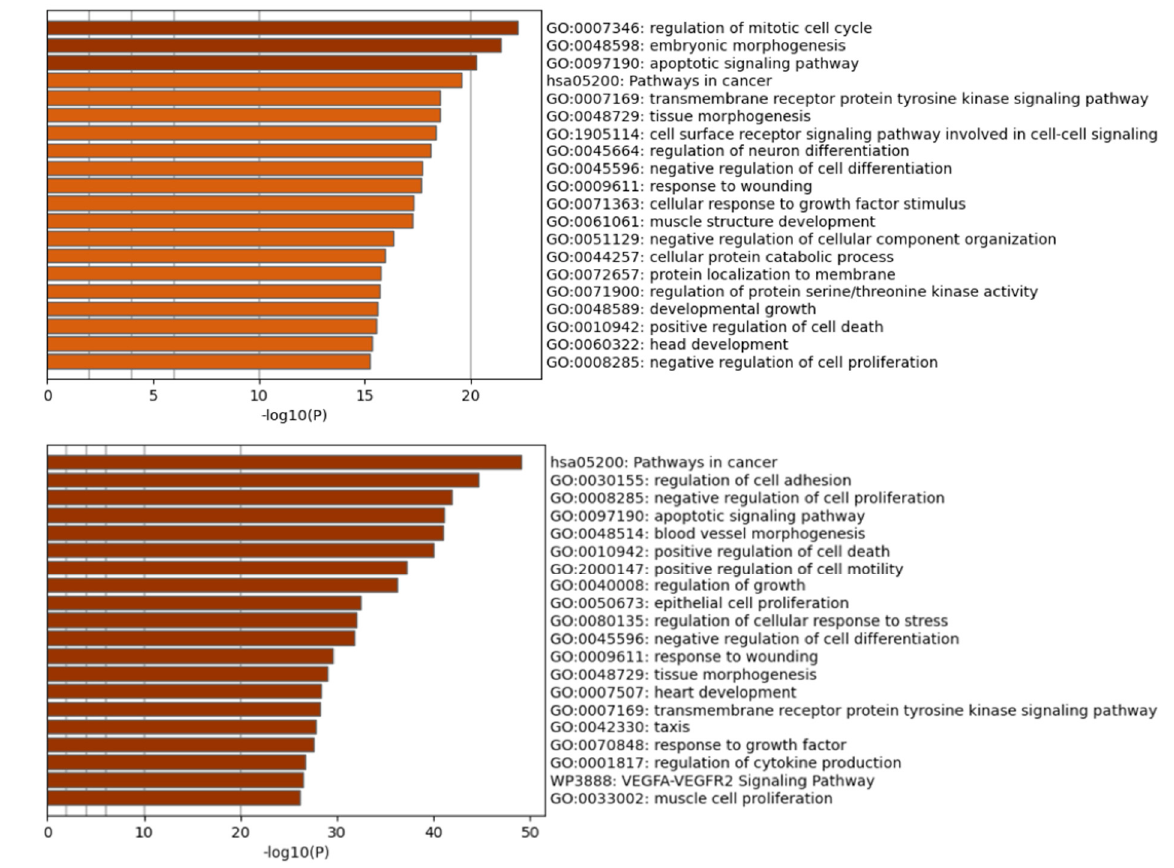
Figure 4. Top GO and KEGG terms using Metascape for ( A ) 2737 genes annotated to methylation biomarkers and ( B ) for 383 metastatic genes mapped using HCMDB.